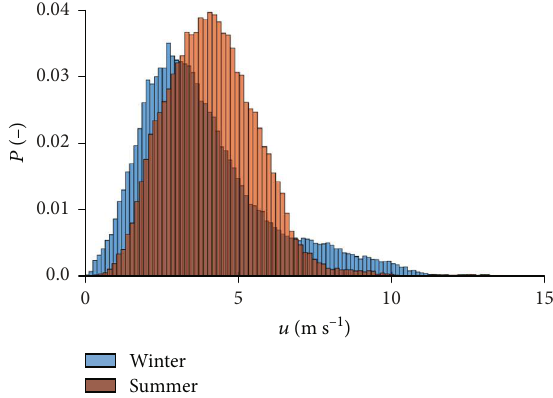
Figure 29: Winter (May-Aug) and summer (Jan-Apr) afternoon (1200 - 1800 LT) wind speed ( u ) probability ( P ) for 1990-2009 for West Campus